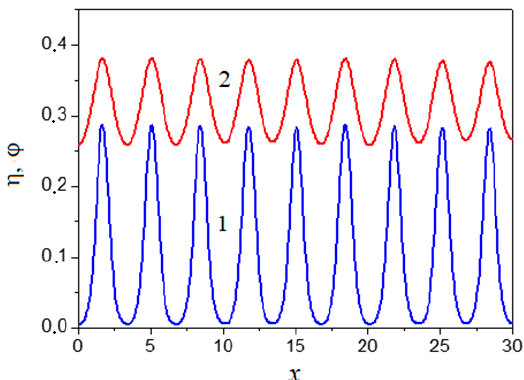
Figure 4. Spatial distribution of the variables ϕ (curve 1) and η (curve 2) on l 2 = 1.4 .